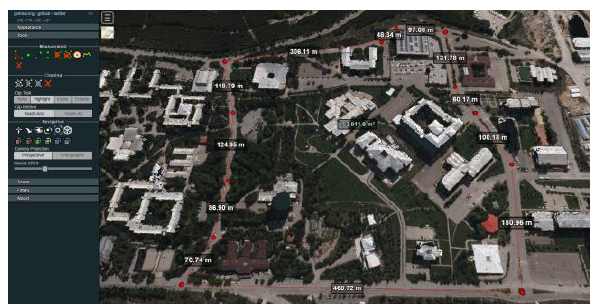
Figure 8. Using area measuring tool on Potree web